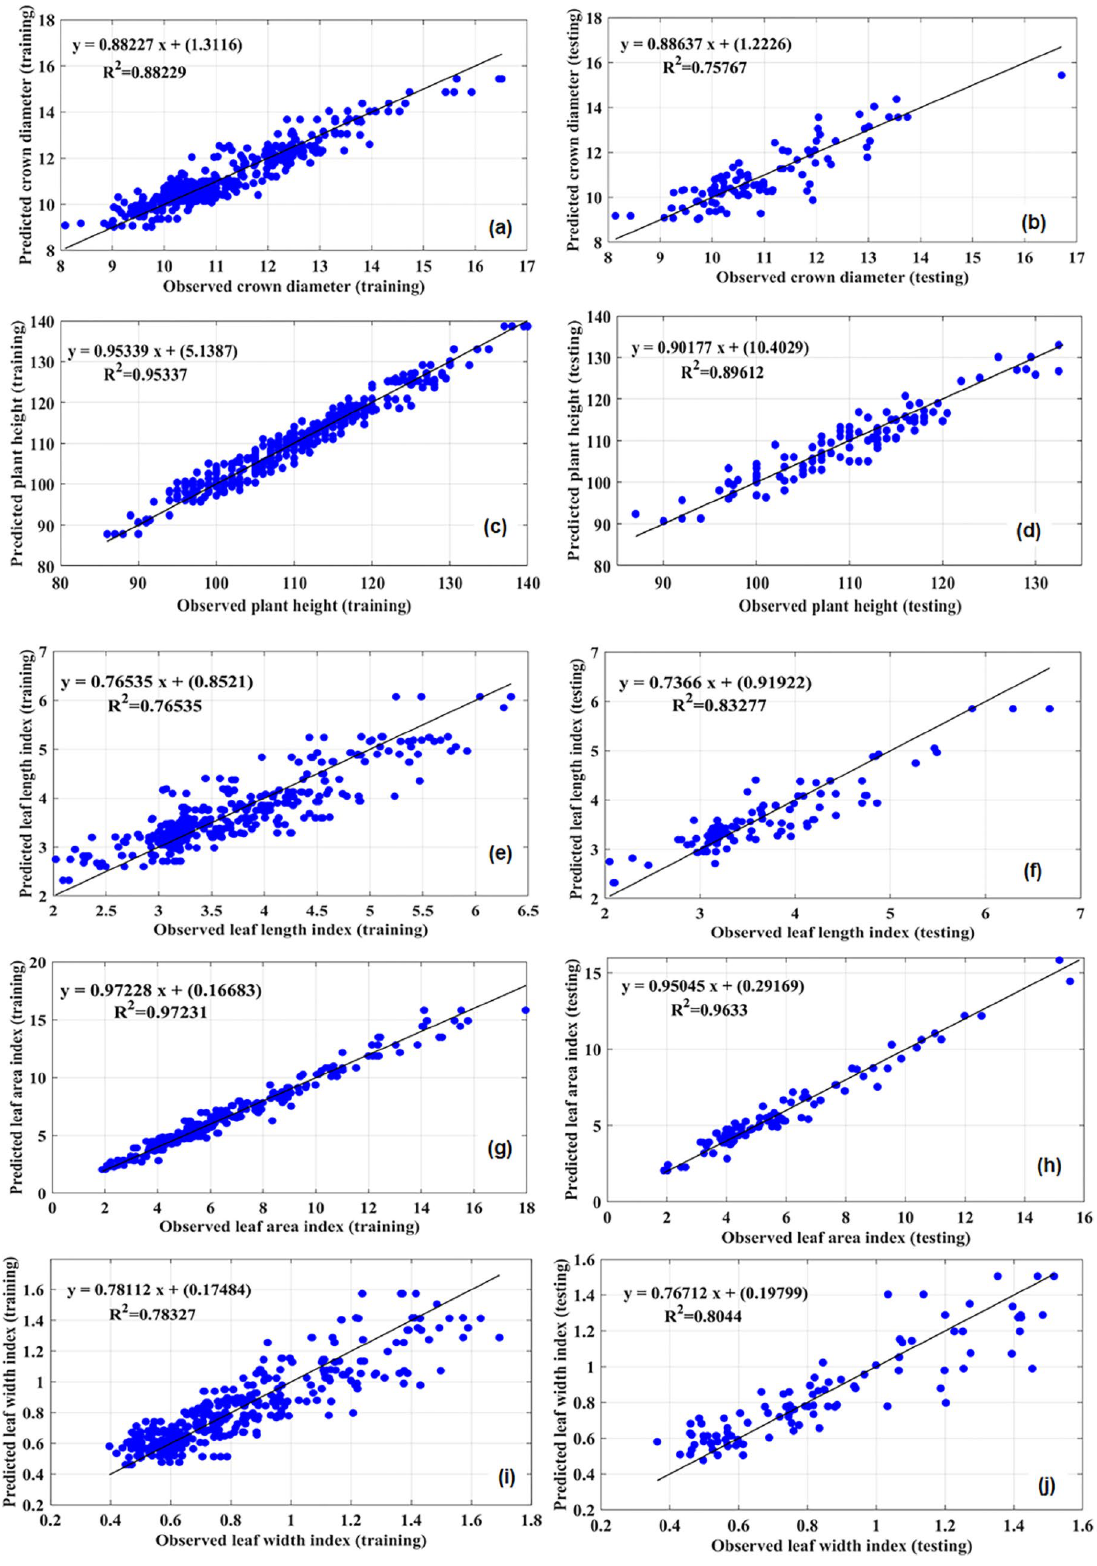
Figure 3. The scatter plot of observed values vs. predicted values of ( a , b ) crown diameter (Training) and (Testing), ( c , d ) plant height (Training) and (Testing), ( e , f ) leaf length index (Training) and (Testing), ( g , h ) leaf width index (Training) and (Testing), ( i , j ) leaf area index (Training) and (Testing) obtained by multilayer perceptron (MLP)